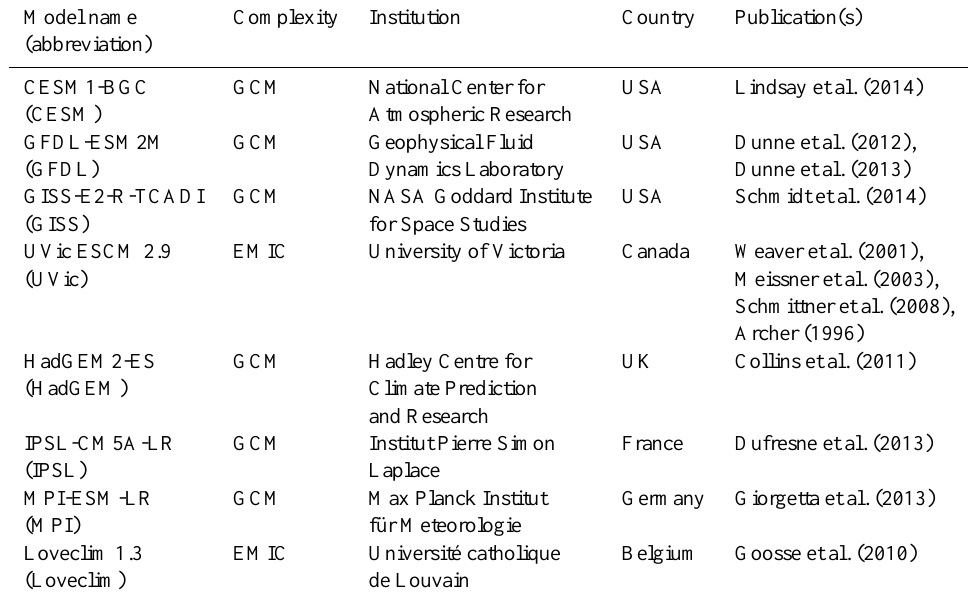
Table 1. Information about each model including its full configuration name and an abbreviation for use in the text, level of complexity (GCM or EMIC), the name and location of its host institution, and the relevant publication(s) describing the given